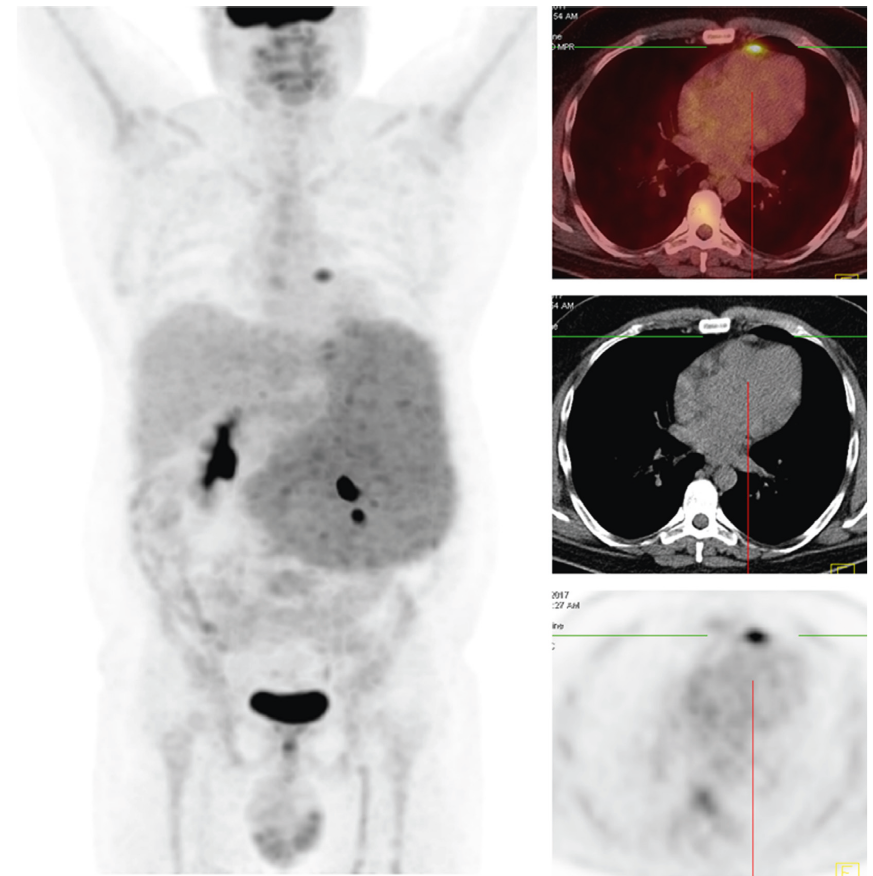
Figure 6: Positron emission tomography-computed tomography. Enlarged pericardial lymph node in the anterior mediastinum with SUVmax (cid:136) 6.1.